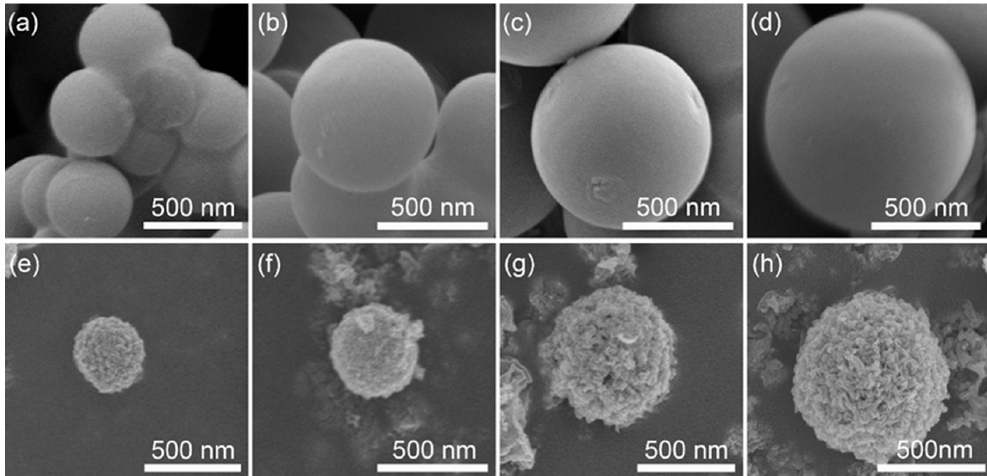
Figure 1. ( a – d ) SEM images of carbonaceous spheres (CS) with different sizes synthesized by tuning concentration of sucrose; ( e – h ) SEM images of TiO 2 hollow microspheres (HMS) fabricated by different sizes of CS templates.